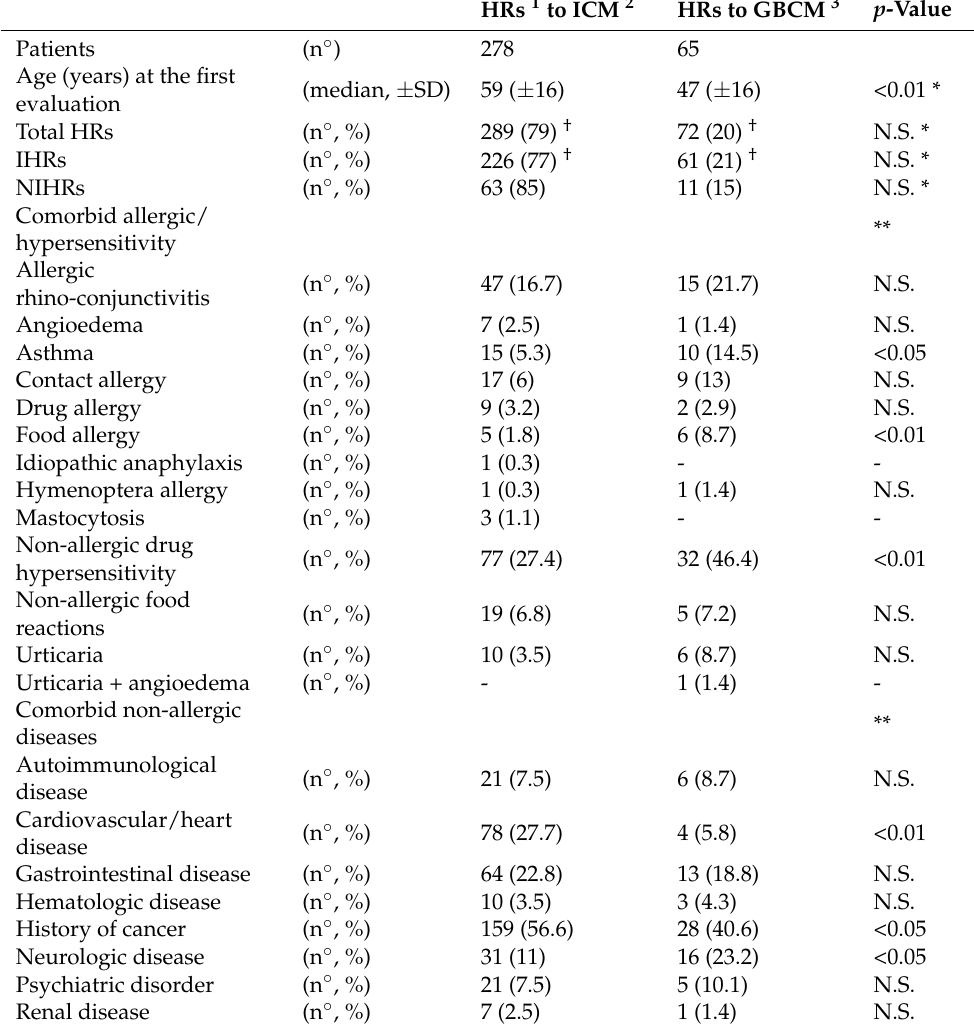
Table 2. Comparison between patients with HRs to ICM and patients with HRs to